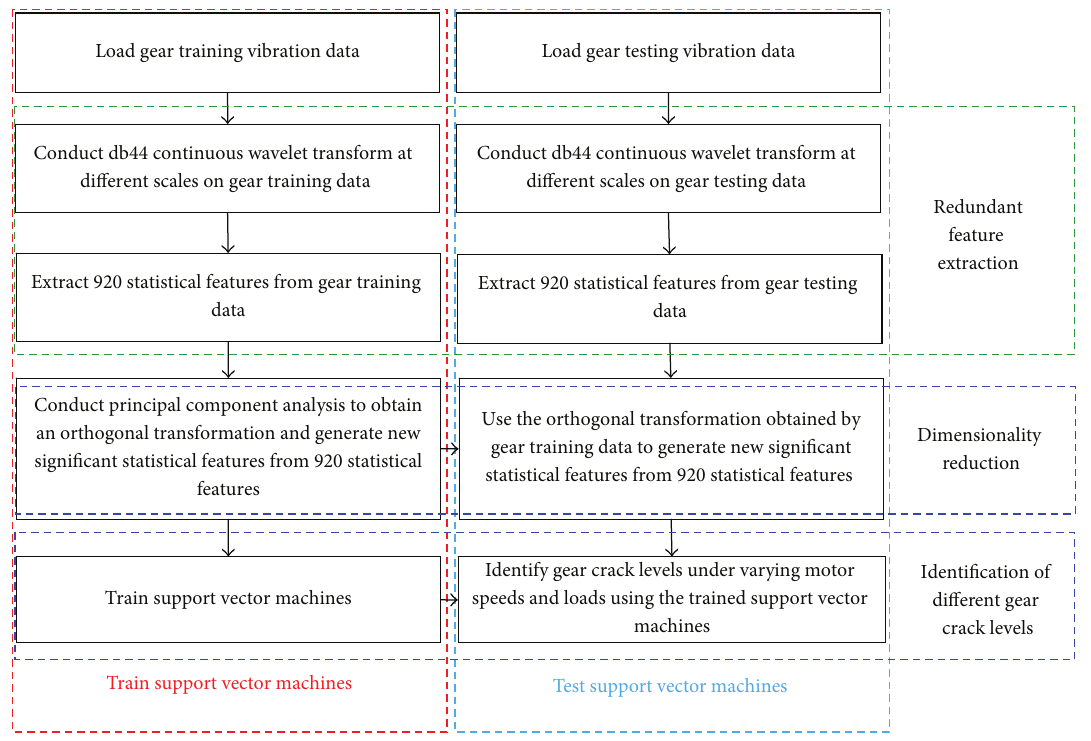
to generate 920 dimensional redundant statistical features for the representation of the gear crack level. The dimensionality of the redundant statistical features is calculated as